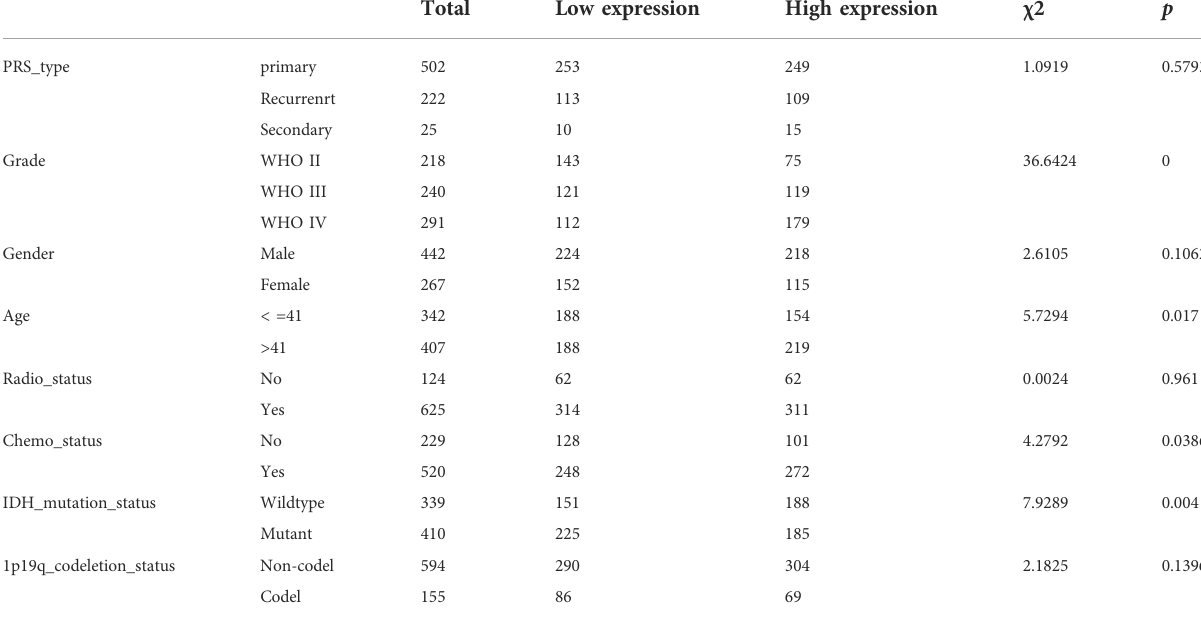
TABLE 1 Baseline of CGGA patients ’ information.